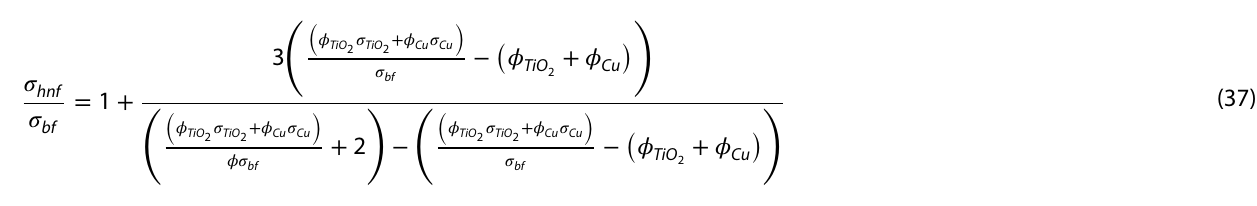
Fig. 4 Effect of heat generation variation (Q = {0.1,0.2,0.3,0.4,0.5, 1} from left to right) on contours of streamlines (1st row), isotherms of fluid phase (2nd row), isotherms of solid phase (3rd row), isocon-